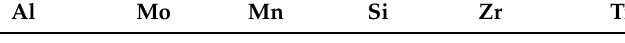
Table 1. Chemical composition of TC11.